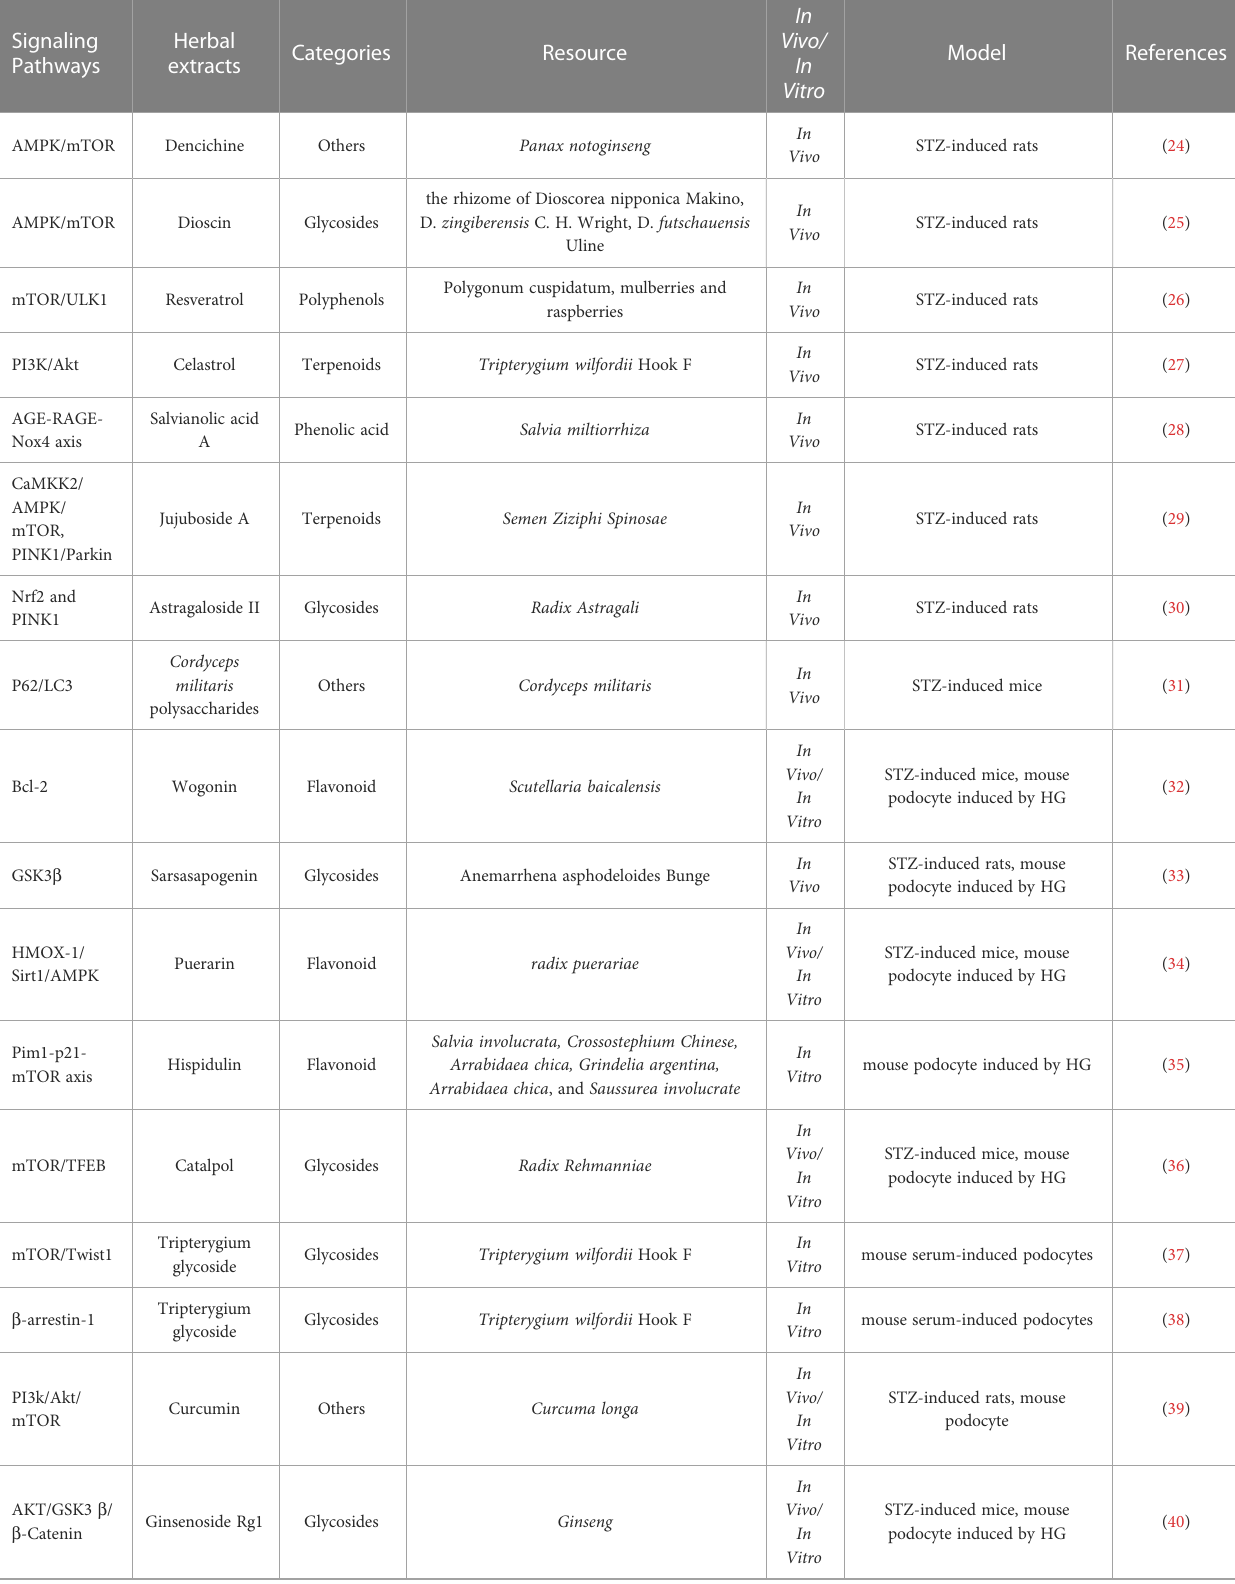
TABLE 3 The role of active compounds against renal injuries via regulating autophagy in DKD.